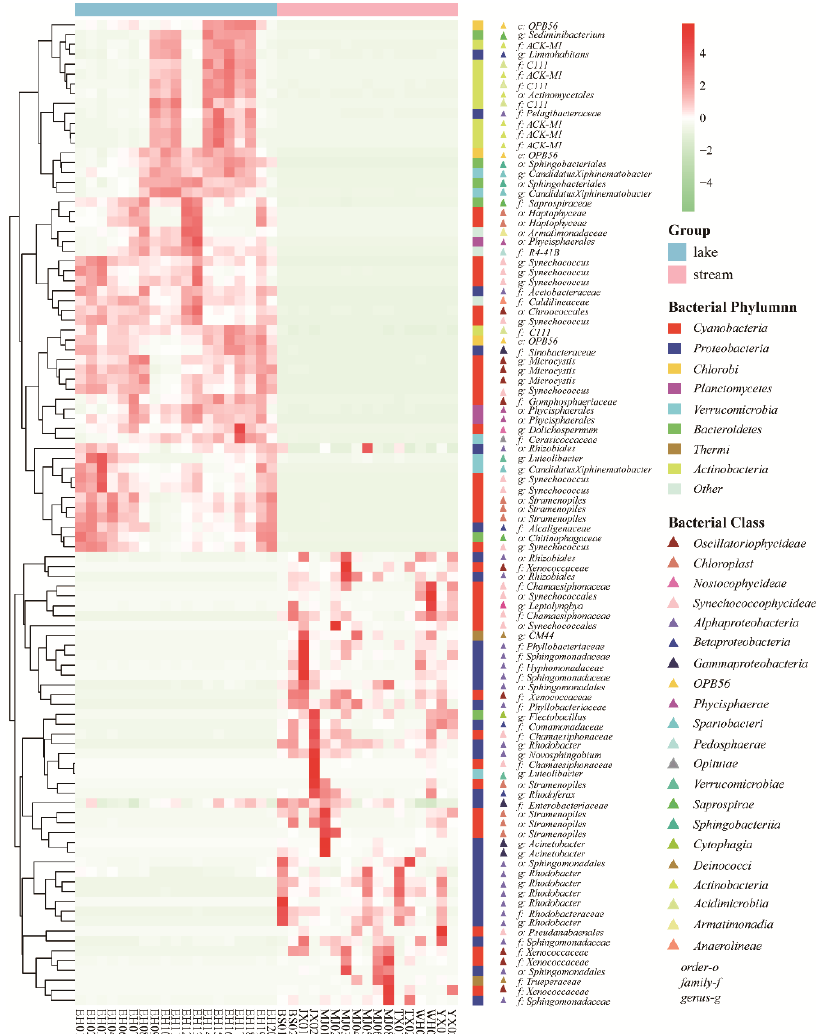
Figure 4. Heatmap showing the taxonomic differences of OTUs between Erhai Lake and streams based on Bray–Curtis distance. Bray–Curtis distances were calculated using relative abundances of OTUs (relative abundance > 0.1%).